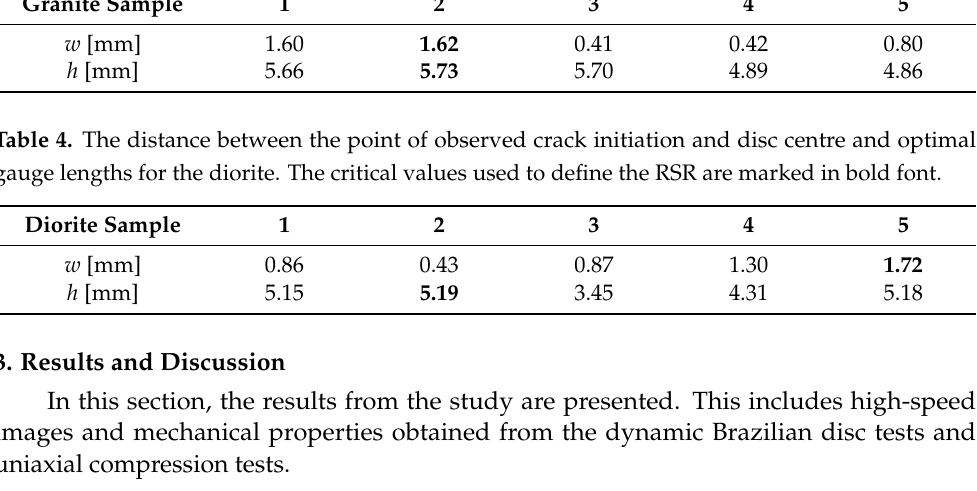
Table 3. The distance between the point of observed crack initiation and disc centre and optimal gauge lengths for the granite. The critical values used to define the RSR are marked in bold font. Granite Sample 1 2 3 w [mm]